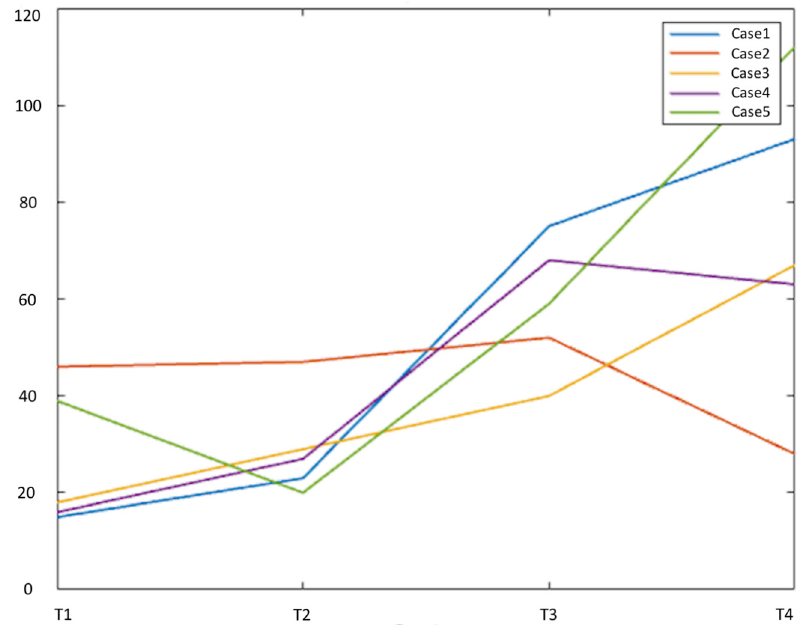
Figure 5. Graphical representation of the total number of intra- and inter-hemispheric connections between active fMRI clusters across the four timepoints of our study. Each case is represented as a colored line (legend in the figure). The number of links is depicted in the y-axis, while the timepoints are shown on the x-axis of the graph. All cases demonstrated an increased number of links from the first to the last timepoint, with the exception of case 2 (orange line).